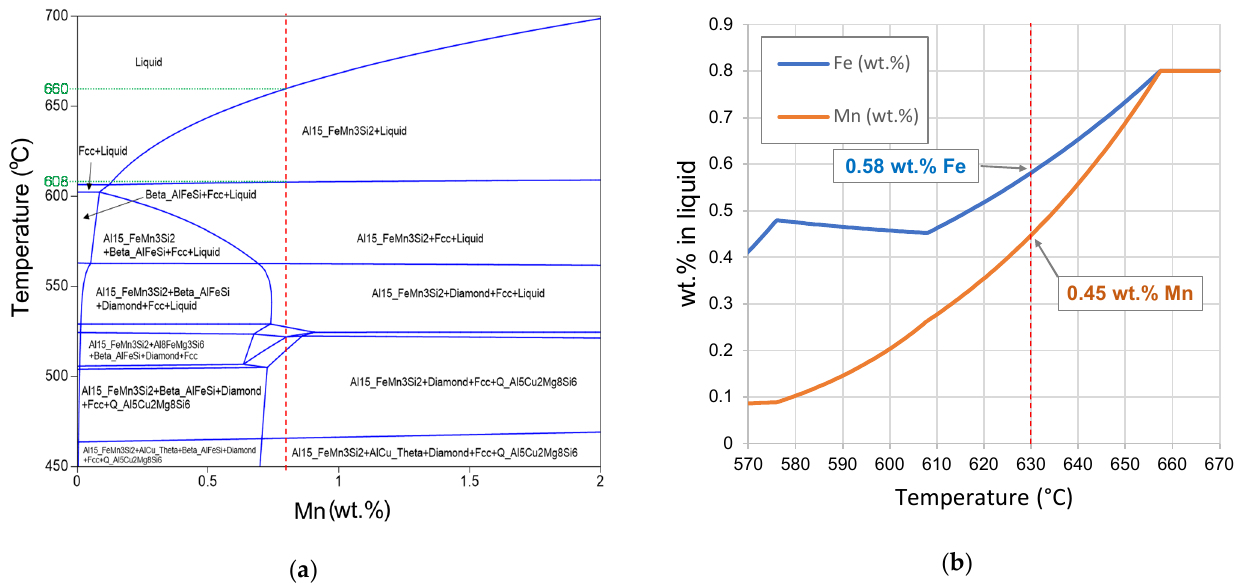
Figure 6. ( a ) Equilibrium phase diagram of the as-received Zorba cast fraction–xMn system, ( b ) Liquid composition of Zorba cast fraction alloy with the addition of 0.8 wt.% Mn for the second trial.